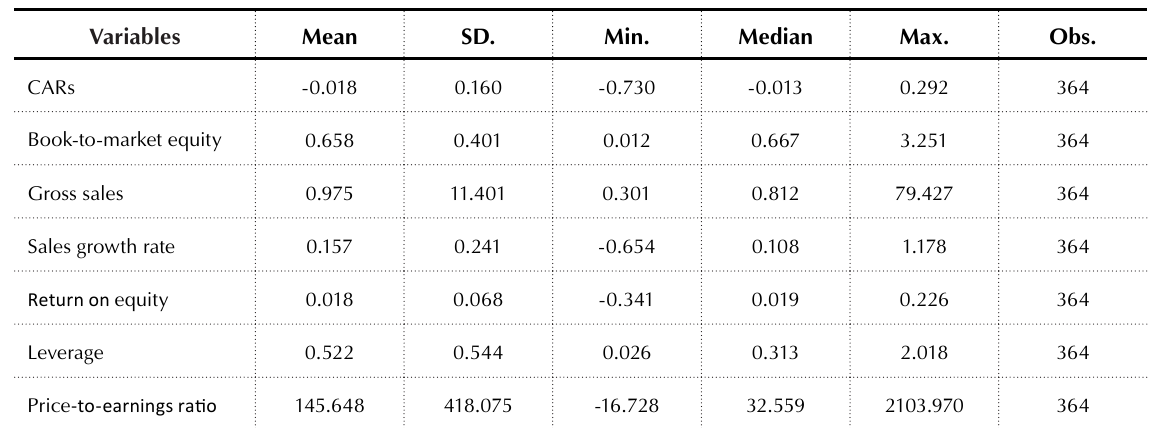
Table 3. Descriptive statistics during the event window (-20,